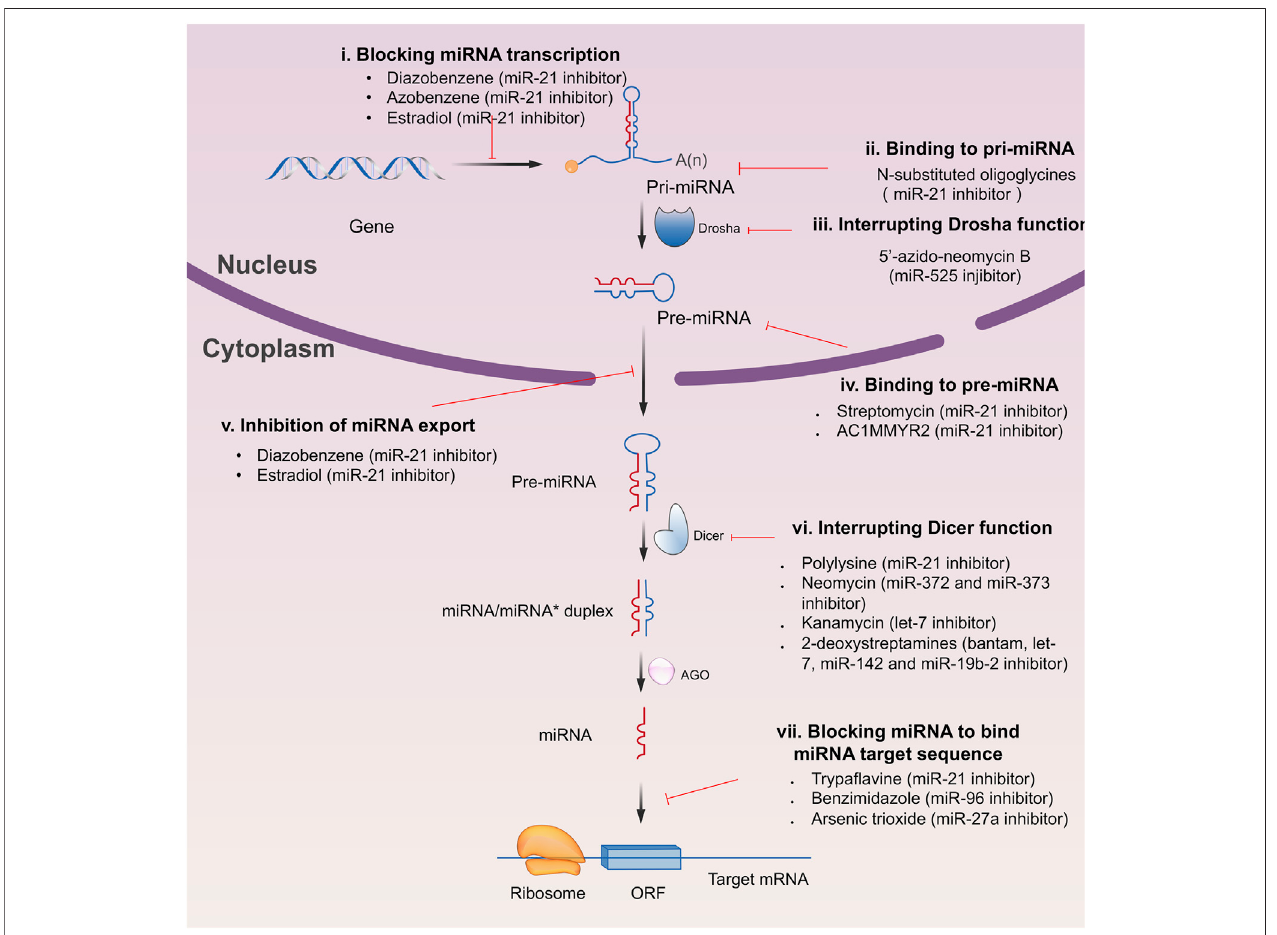
FIGURE 4 | Schematic illustration of different inhibition mechanisms of miRNA speci fi c small molecule inhibitors.